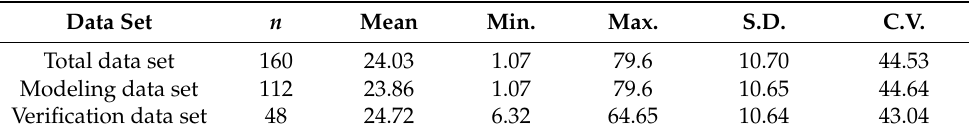
Table 2. Descriptive statistics of the total, modeling, and verification soil EC data sets.